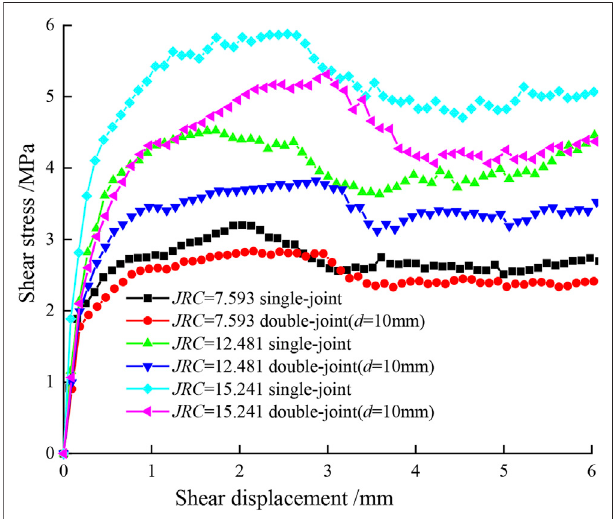
FIGURE 5 | Shear displacement-stress relation of single- and double- joint